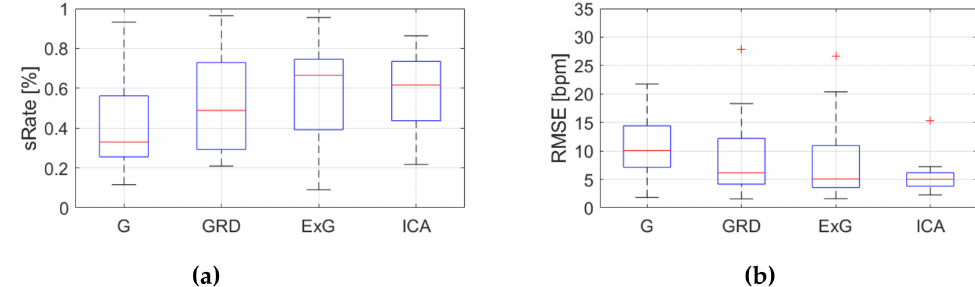
Figure 16. Comparison of signal extraction methods, algorithm No.2 (AR), part 6: ( a ) box plots for sRate ; ( b ) box plots for RMSE . Blue lines—IQR range, red line—median value.